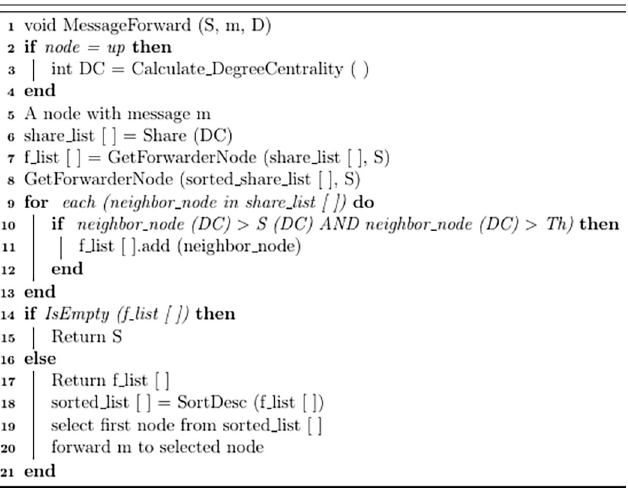
Fig 4. Pseudocode of our proposed routing scheme